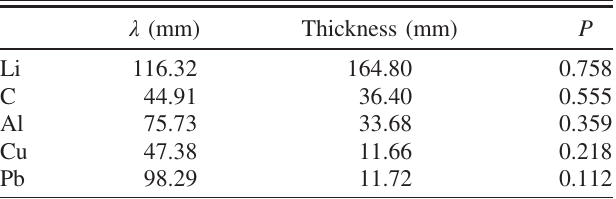
TABLE V. The mean free path λ and probability of fragmenta- tion P for 1 GeV = u 208 Pb ions penetrating through matter that causes a 20% velocity reduction, calculated by using the EPAX formula with the aid of the program LISE ++ [20]. The exiting energy is 373 MeV =